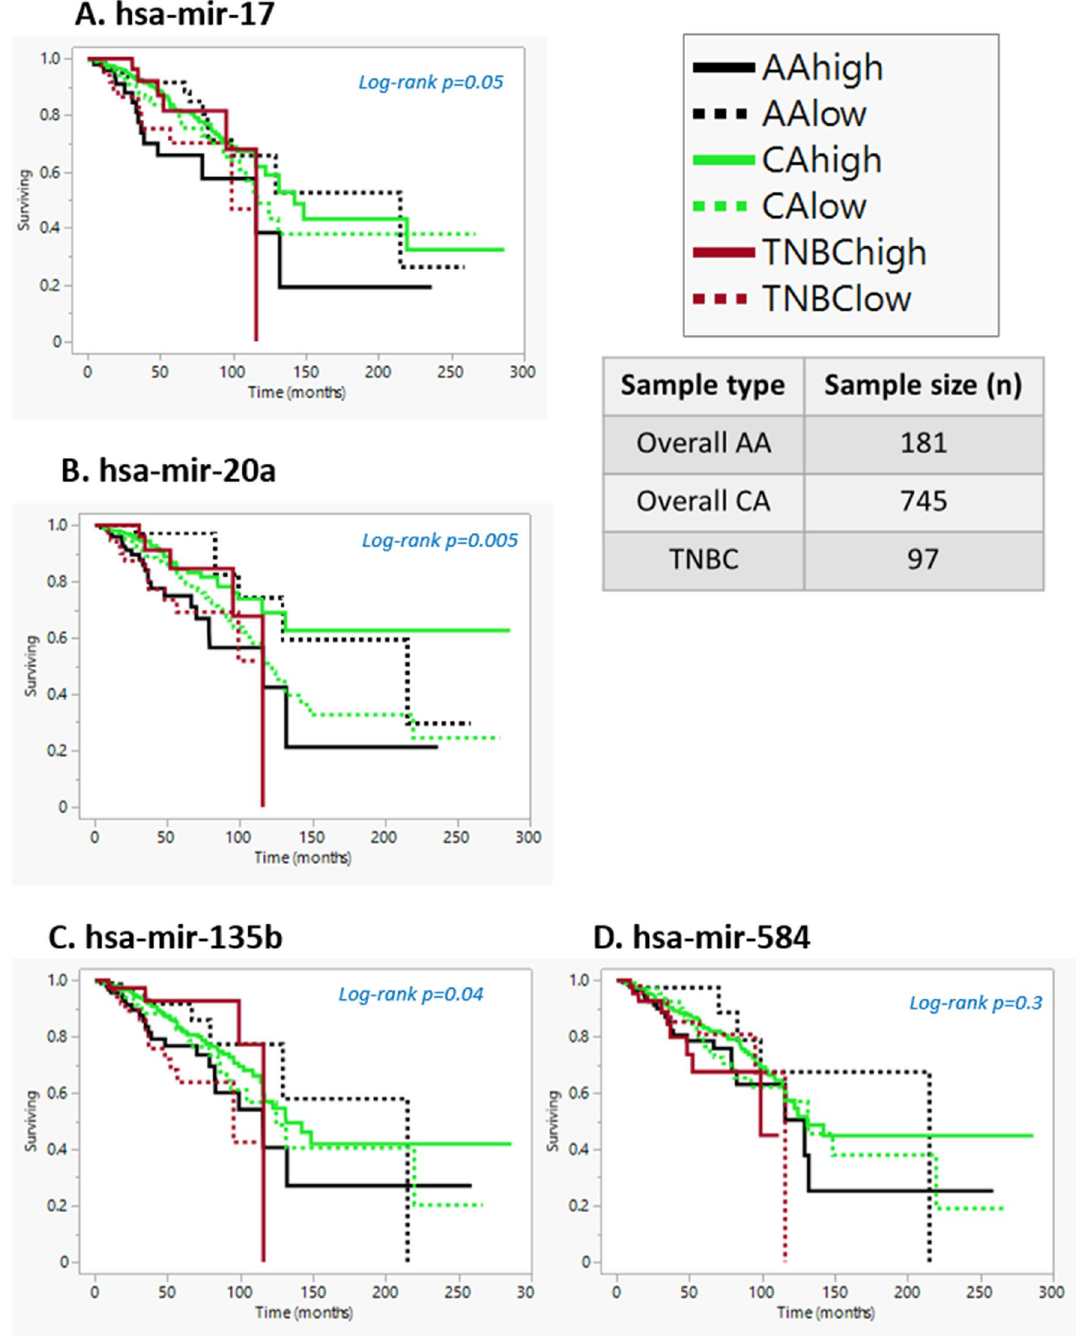
Figure 3. Survival analysis for mir-17, mir-20a, mir-135b, and mir-584 in overall AAs (n = 181), Overall CA (n = 745), and TNBCs (n = 97). AA patients with high levels of hsa-mir-17 or mir 20a or mir135b have